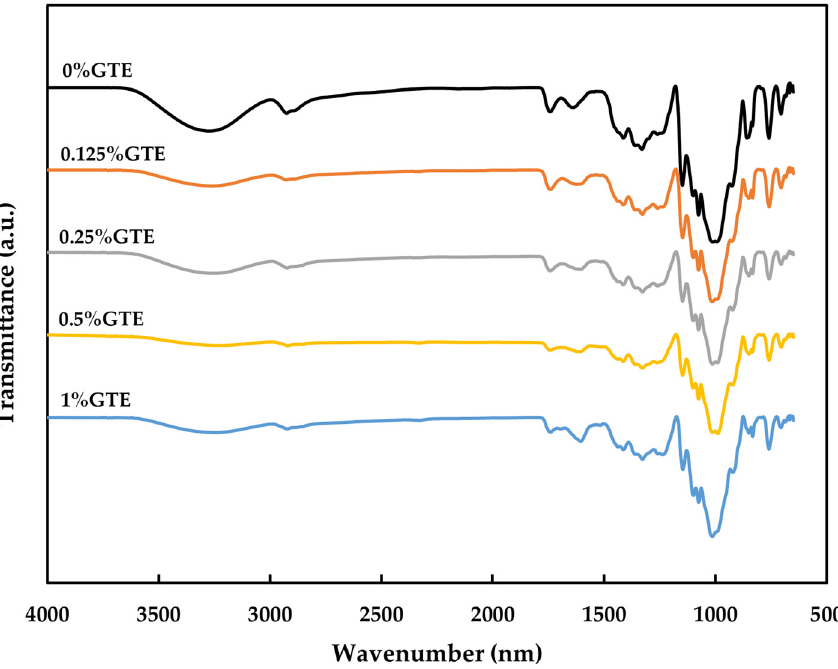
Figure 2. FT - IR spectra of RS - P composite films incorporated with green tea extract at different Figure 2. FT-IR spectra of RS-P composite films incorporated with green tea extract at different concentrations . Numbers denote the concentrations of GTE (% , w / v ). concentrations. Numbers denote the concentrations of GTE (%, w / v